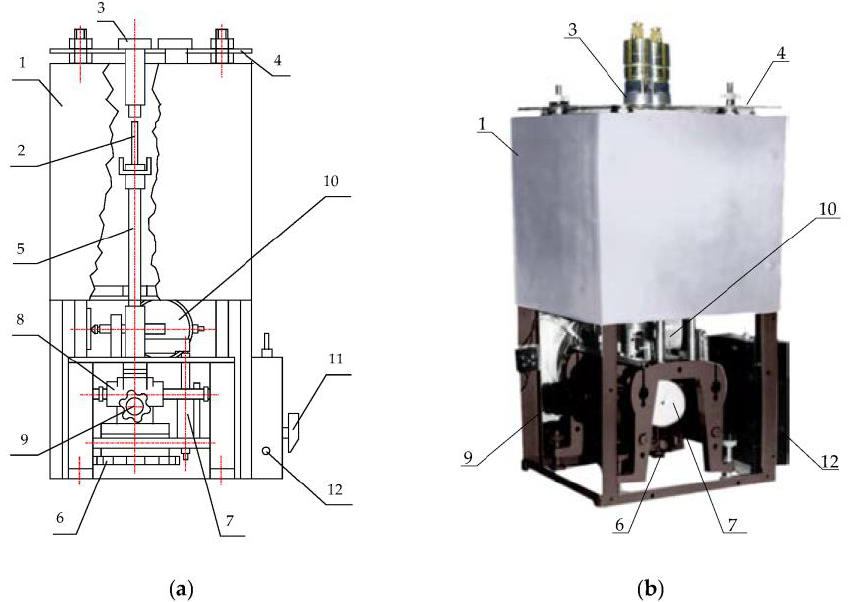
Figure 6. Special device for calibration of the measuring channels with SCECS: schematic view ( a ) and design of the device with working and compensative SCECS ( b ). 1 — thermal chamber, 2 — fragment of the monitored object, 3 — bushing, 4 — platform, 5 — ceramic rod, 6 — micrometric screw, 7 — dial indicator, 8 — carriage, 9 — handwheel, 10 — dial indicator, 11 — regulator switch, 12 — LED indicator.